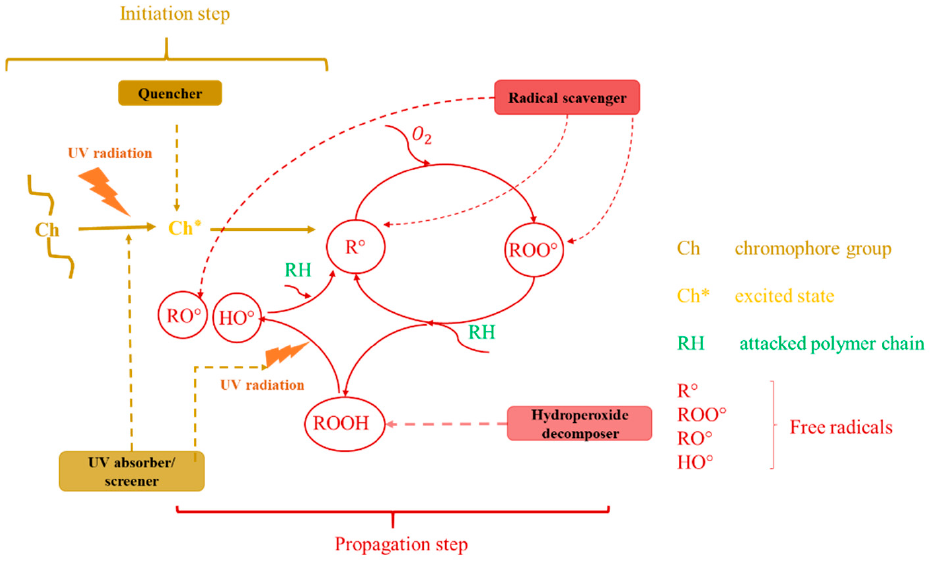
Figure 1. General pathways of photodegradation and stabilization mecha-